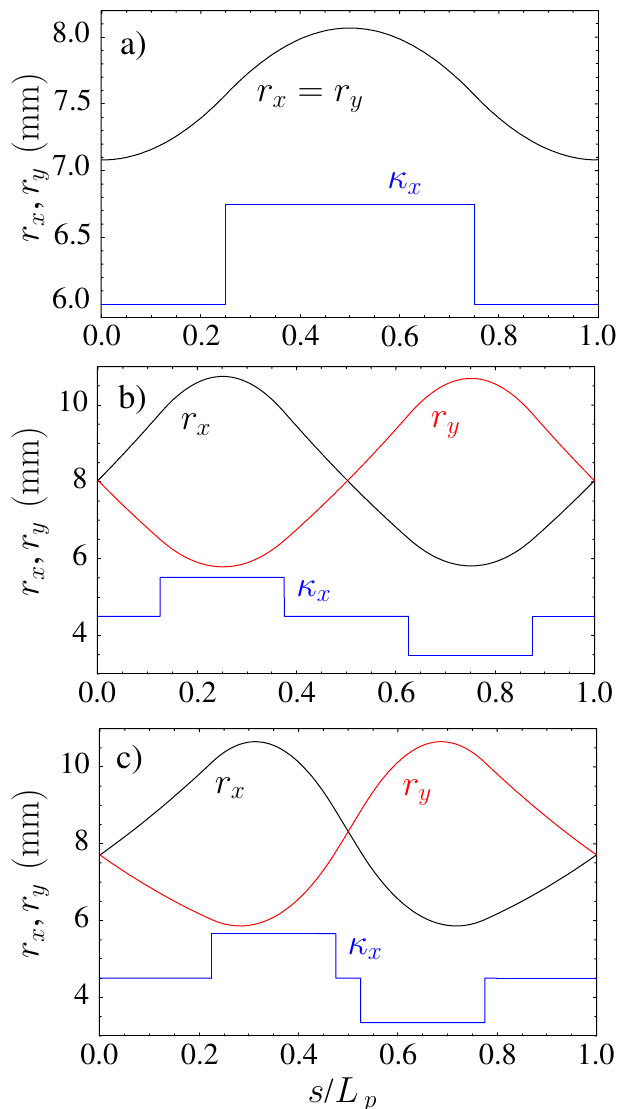
FIG. 2. (Color) Example matched envelope solutions for (a) solenoidal, (b) FODO ( (cid:7) (cid:2) 1 = 2 ) quadrupole, and (c) syncopated ( (cid:7) (cid:2) 0 : 1 ) quadrupole focusing lattice. Parameters for all cases (cid:2) 0 : 5 m , (cid:9) (cid:2) 0 : 5 , (cid:6) (cid:2) 80 (cid:10) , Q (cid:2) 4 (cid:9) 10 (cid:1) 4 , and " (cid:2) are: L p 0 (cid:2) 0 : 3144 , 0 : 3093 , 50 mm mrad . These parameters yield (cid:6)=(cid:6) 0 and 0 : 3099 for (a), (b), and Typical matched envelope solutions r are shown for one j lattice period in Fig. 2 for solenoid, FODO ( (cid:7) (cid:2) 1 = 2 ) quadrupole, and syncopated ( (cid:7) (cid:1) 1 = 2 ) quadrupole focus- ing lattices. Scaled x -plane lattice focusing functions (cid:3) x are shown superimposed. Excursions of the matched enve- (cid:2) lope functions are in-phase for solenoidal focusing ( r x (cid:2) r ) because the applied focusing is plane symmetric ( (cid:3) y x (cid:3) ). In contrast, for quadrupole focusing, the antisymmet- y (cid:2) (cid:1) (cid:3) ) results in out of phase ric plane focusing ( (cid:3) x y envelope flutter in each plane (focus-defocus) leading to net focusing over the full lattice period in both planes.